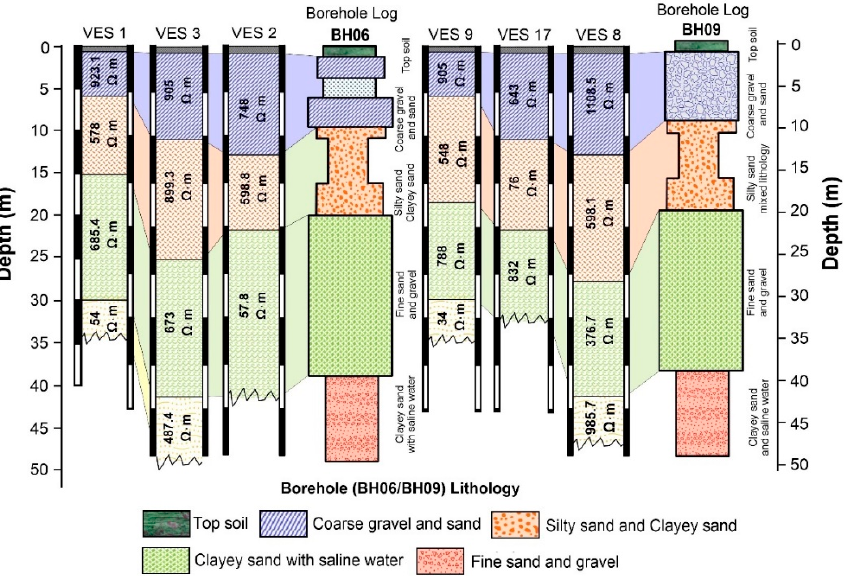
Figure 12. Correlation of VES data interpretation results with borehole lithological